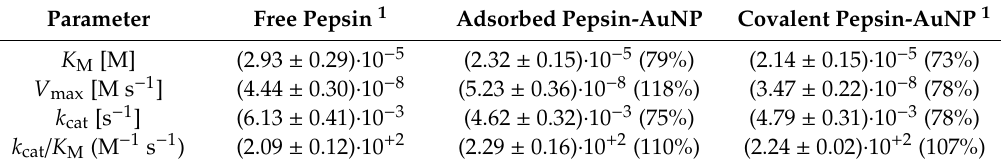
Table 8. Comparison of kinetic data for digestion of cytochrome C as model